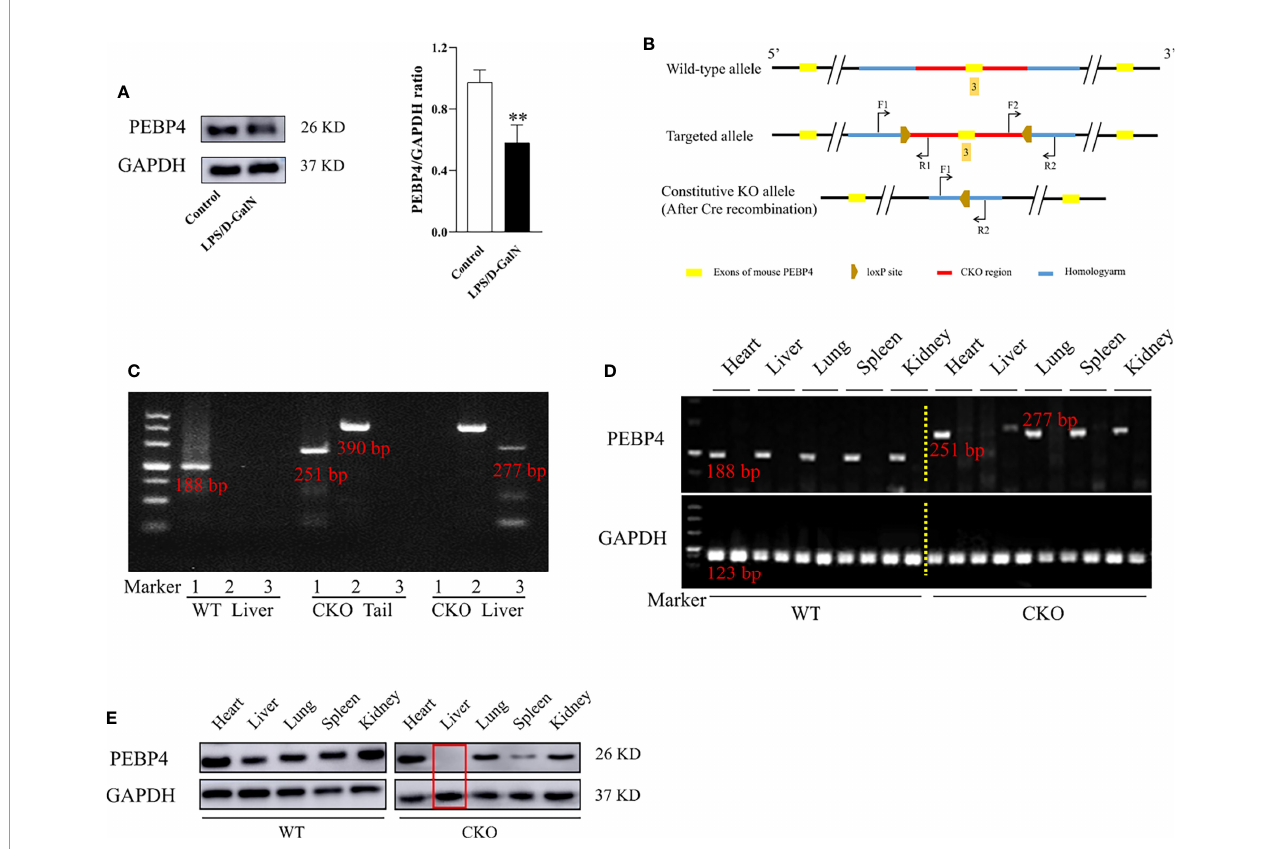
FIGURE 1 | PEBP4 hepatocyte-conditional knockout (CKO) mice were constructed and identi fi ed. (A) : Western blotting was used to detect the expression of PEBP4. (B) : The undisturbed PEBP4 gene in WT mice (top panel), schematic of loxP sites introduced into exon 3 of the PEBP4 locus for the generation of PEBP4 fl ox/ fl ox mice (middle panel), and schematic for the generation of PEBP4CKO mice (bottom panel). (C) : The LoxP sites fl anking the PEBP4 gene, the Cre transgene and PEBP4 allele were detected by PCR analysis of tail DNA and liver DNA. (D) : Agarose gel electrophoresis was employed to examine the gene expression of PEBP4 in the heart, liver, lungs, spleen, and kidneys of WT and CKO mice. (E) : PEBP4 protein expression was tested by western blotting in the heart, liver, lungs, spleen, and kidneys of WT and CKO mice. Data are presented as mean ± SD values (n = 3). ** P < 0.01 compared to WT mice in the control